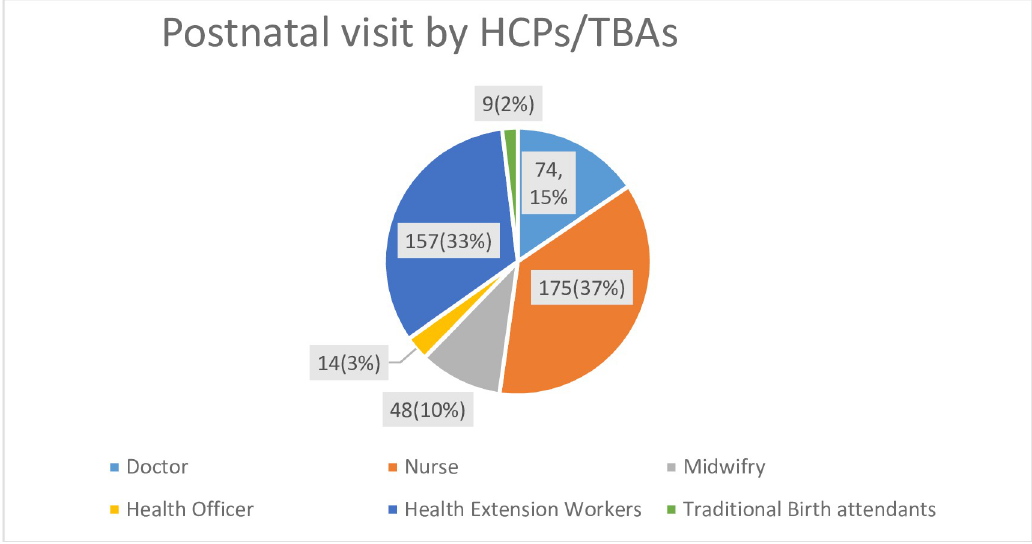
Fig 1. Postnatal care visit at home provided by health care providers,